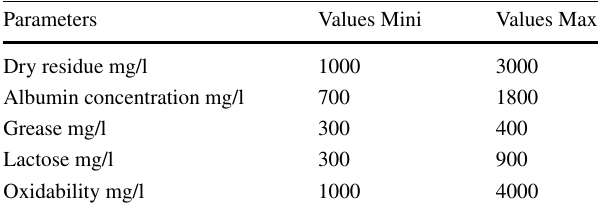
Table 1 Raw contents of sampled wastewater from dairy